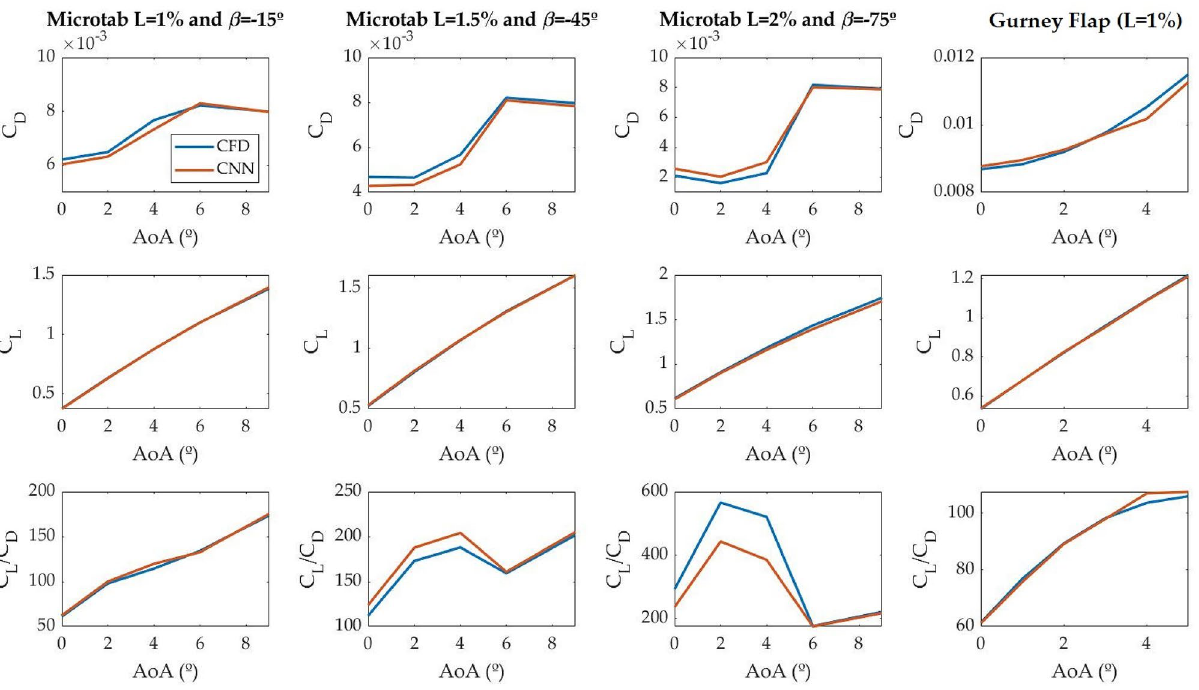
Figure 10. Aerodynamic coefficient comparison of all the tested cases.